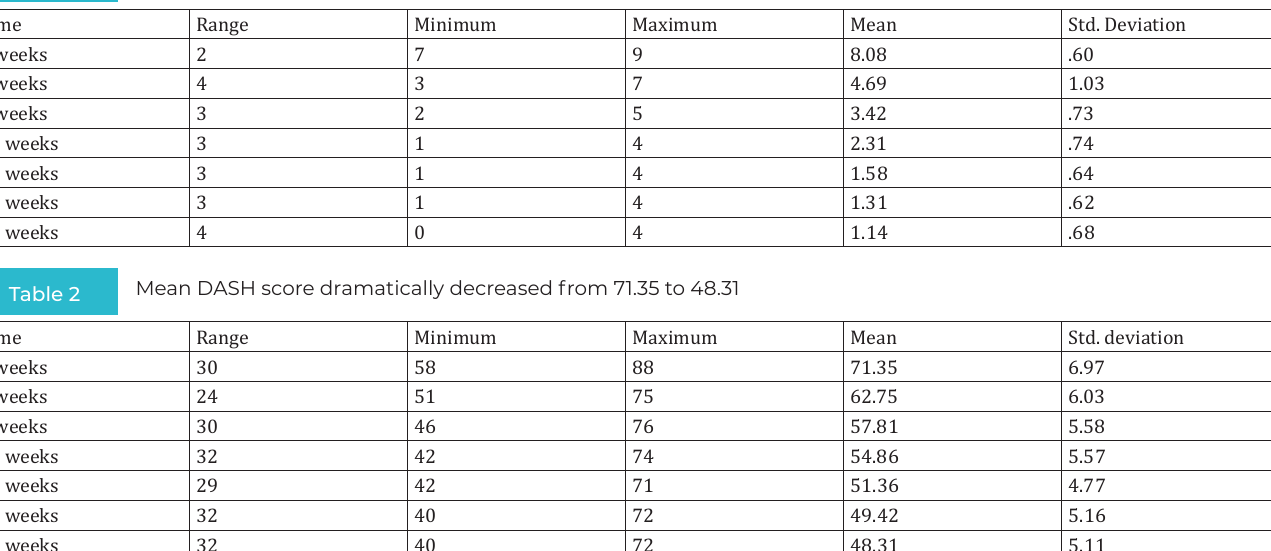
On Visual Analogue Scale mean difference was 6.84 with p value of .0001 at 6 months follow up.